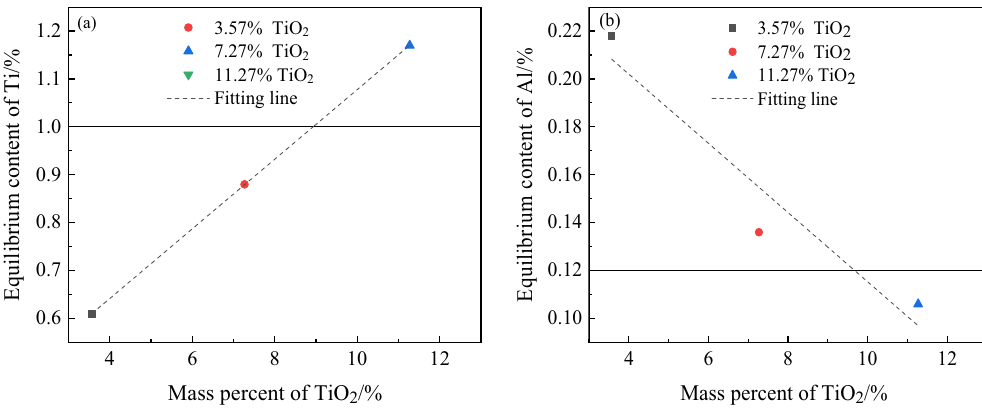
Figure 4: ( a ) and ( b ) Fitting lines of experimental